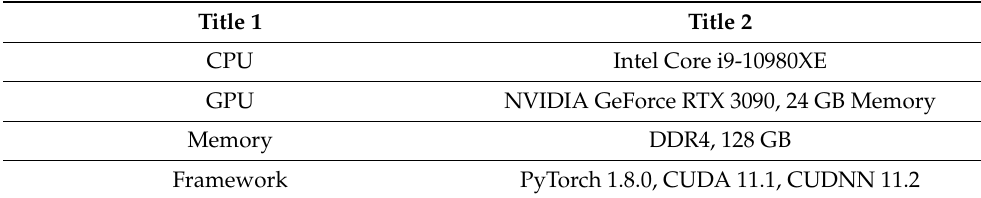
Table 1. Specs of the training